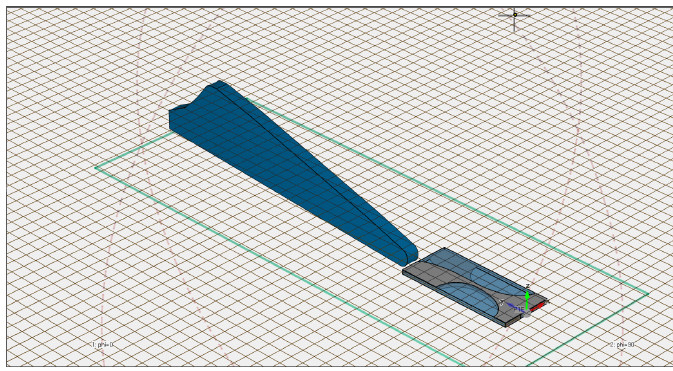
Figure 22. The source is at the backside of the simple blade.